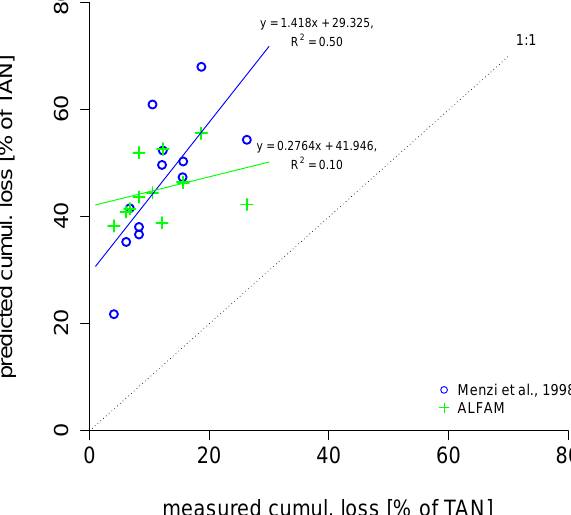
Fig. 3. Predicted vs. measured cumulated NH 3 loss using the em- pirical models ALFAM (Søgaard et al., 2002) and that described by Menzi et al. (1998) for predictions; measured data come from a range of field-scale experiments (splash plate slurry distribution) carried out in Switzerland between 2006 and 2010 using AGM, bLS, and EC (Table A1: ART, Spirig et al., 2010; Sintermann et al.,